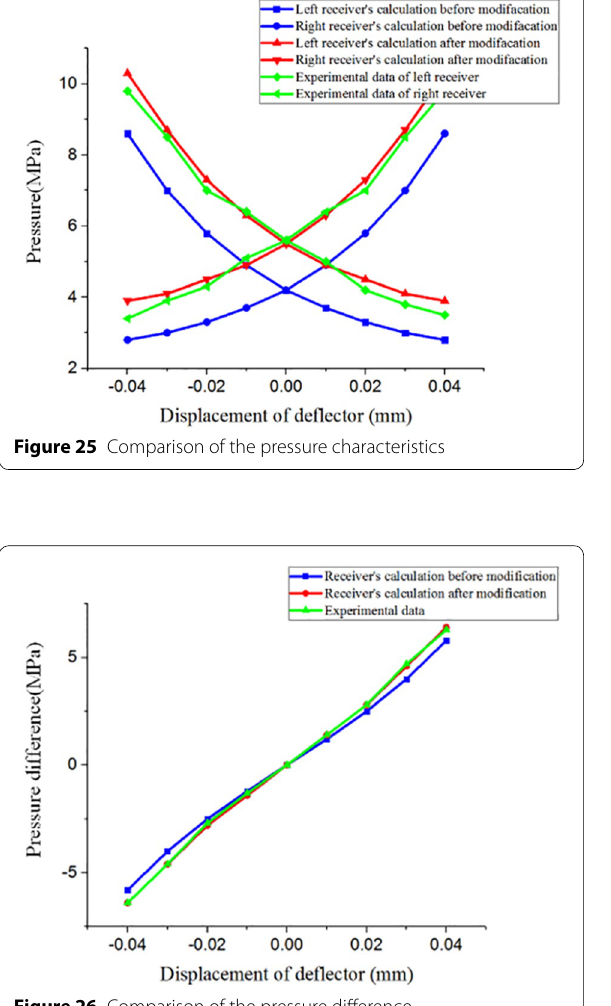
Figure 27. Accordingly, the modification is of great sig- nificance for modeling the servo valve.